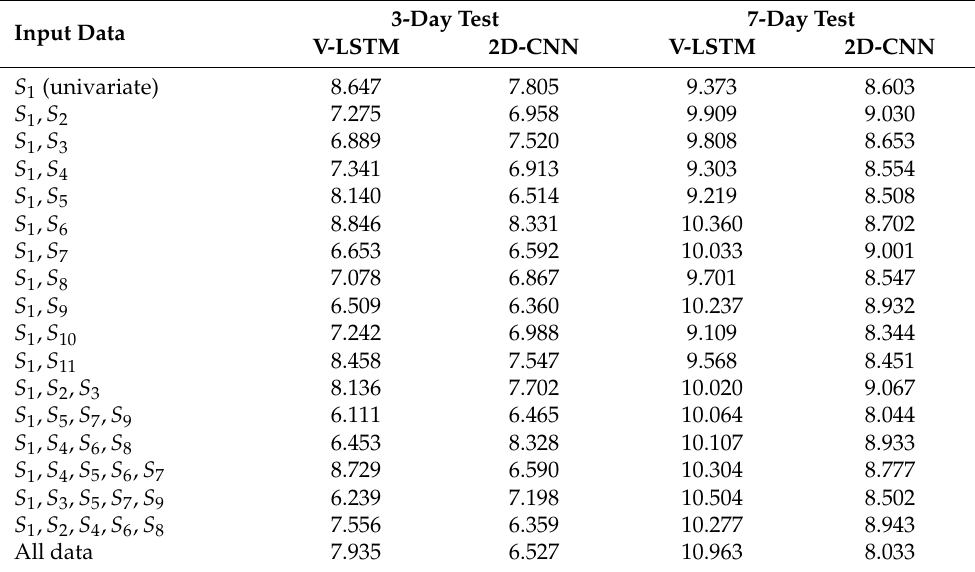
Table 3. Average RMSE for March 2018 tests, carried out by using V-LSTM and 2D-CNN models and different combinations of time